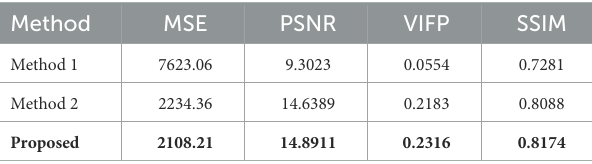
TABLE 2 Reconstructed video frames from RGCs spikes with other